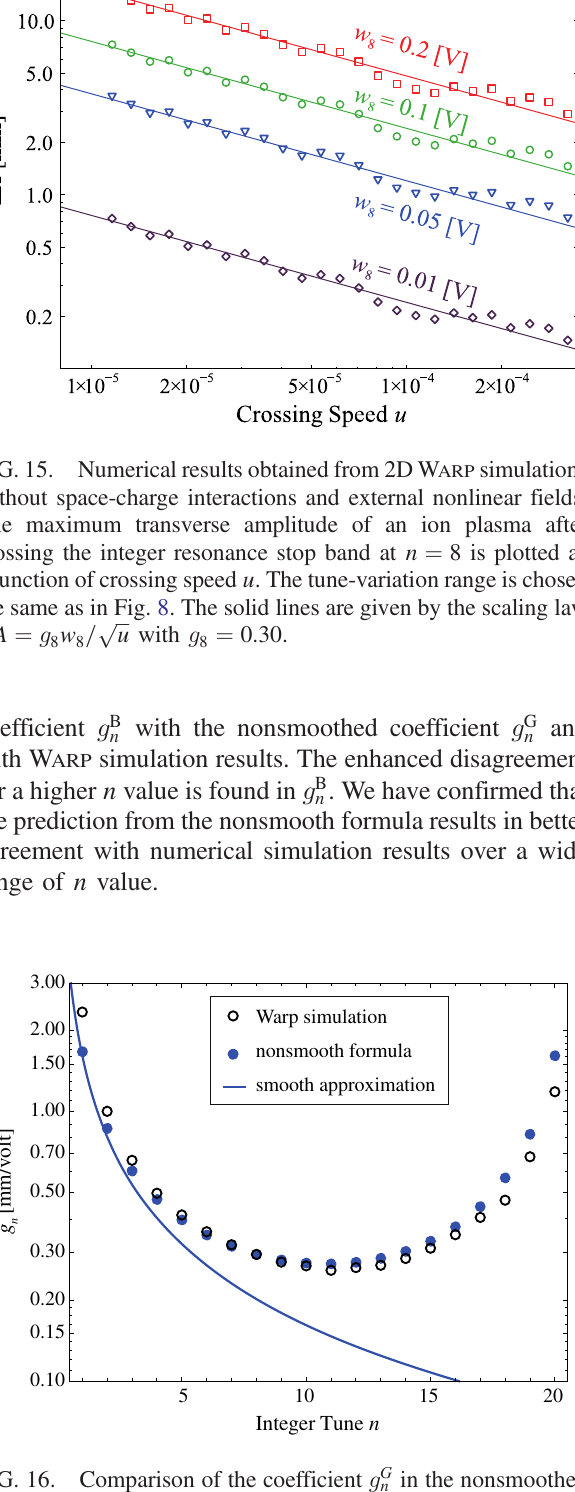
FIG. 16. Comparison of the coefficient g G in the nonsmoothed n scaling formula (8) and g B in the smoothed scaling formula (B1). n The values of g G at different harmonic numbers n are plotted n with black dots. The solid line comes from the definition of g B n in Eq. (B1). Open circles represent the corresponding W ARP simulation